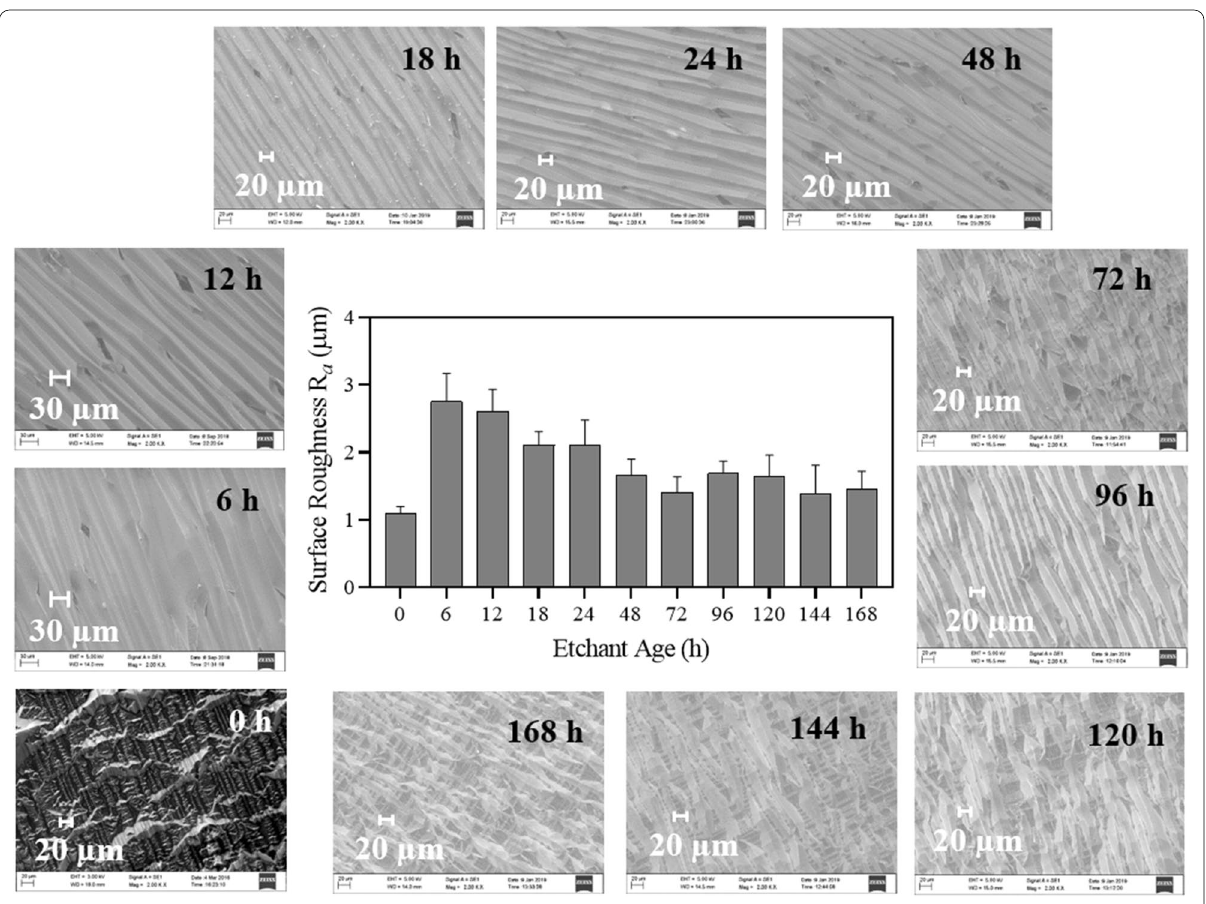
Fig. 49 Surface roughness (Ra) and corresponding surface morphologies of Si{110} with aging time of 15% NH 2 OH-added 20 wt% KOH